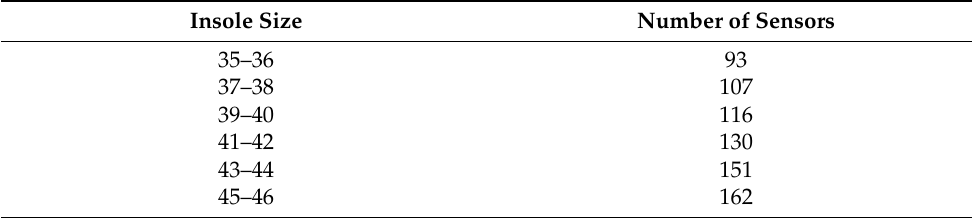
Figure 2. A Medilogic left insole, size 43–44 ( a ) and its corresponding sensor map where each rectangle represents a single sensor ( b ). Table 2. Number of sensors per